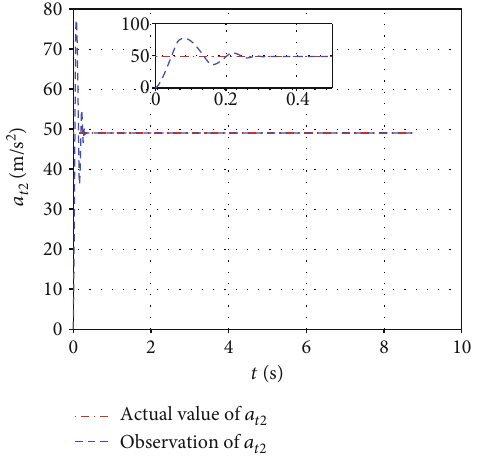
Figure 40: Target acceleration estimation in the lateral plane.